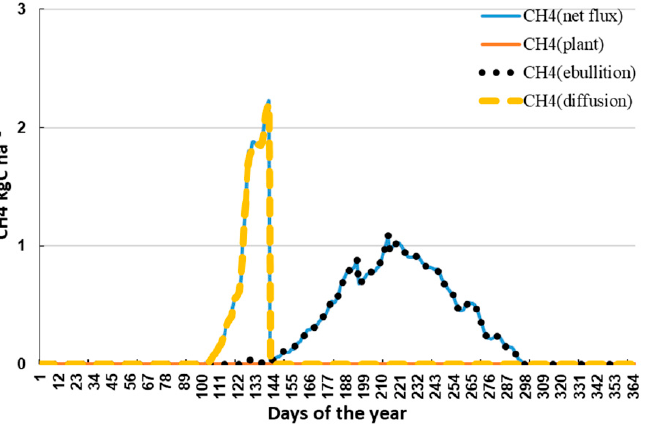
Figure 8. Composite calculated fluxes of CH 4 (kg C ha − 1 day − 1 ) of the Great Vasyugan Mire in 2019.